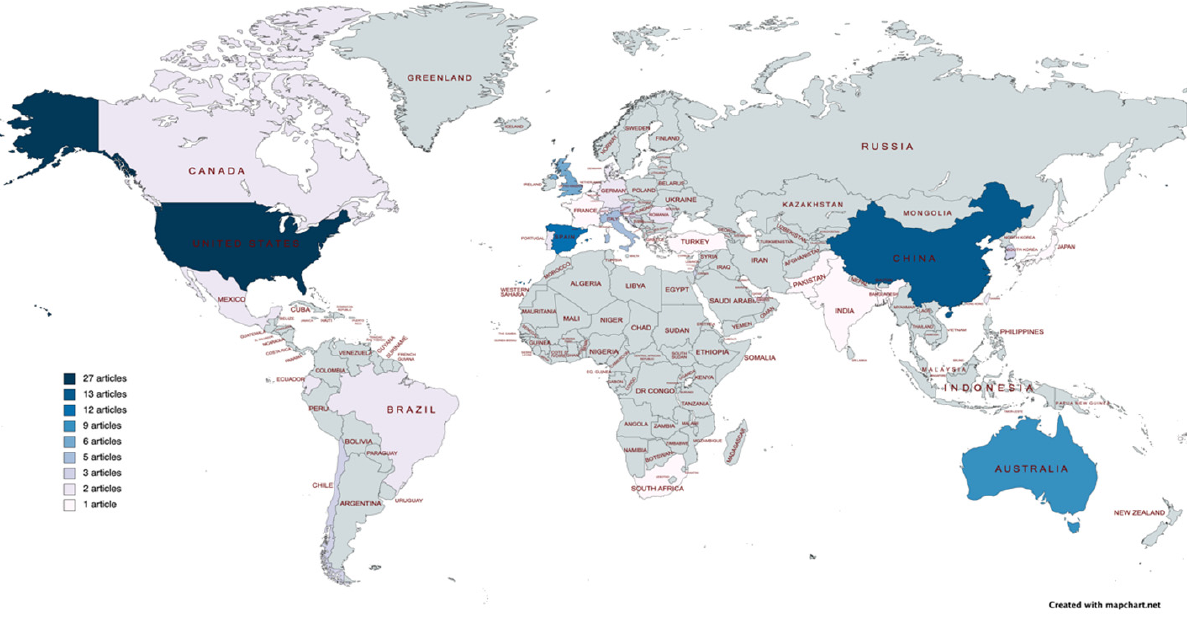
Figure 4. Comparison of countries with the most publications ( ≥ 5 Recs). Note: Recs is the number of articles, TLCS is the local citation score and TGCS is the global citation score. The map below shows the same distribution by country, showing all the countries that published at least 1 article (Figure 5).